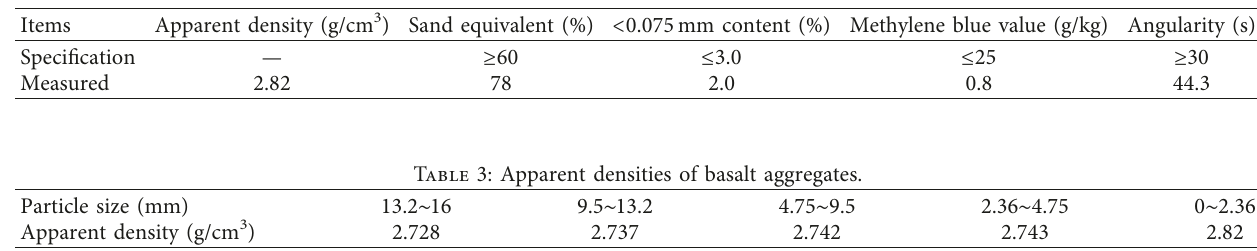
Table 2: Technical indexes of fine aggregates.